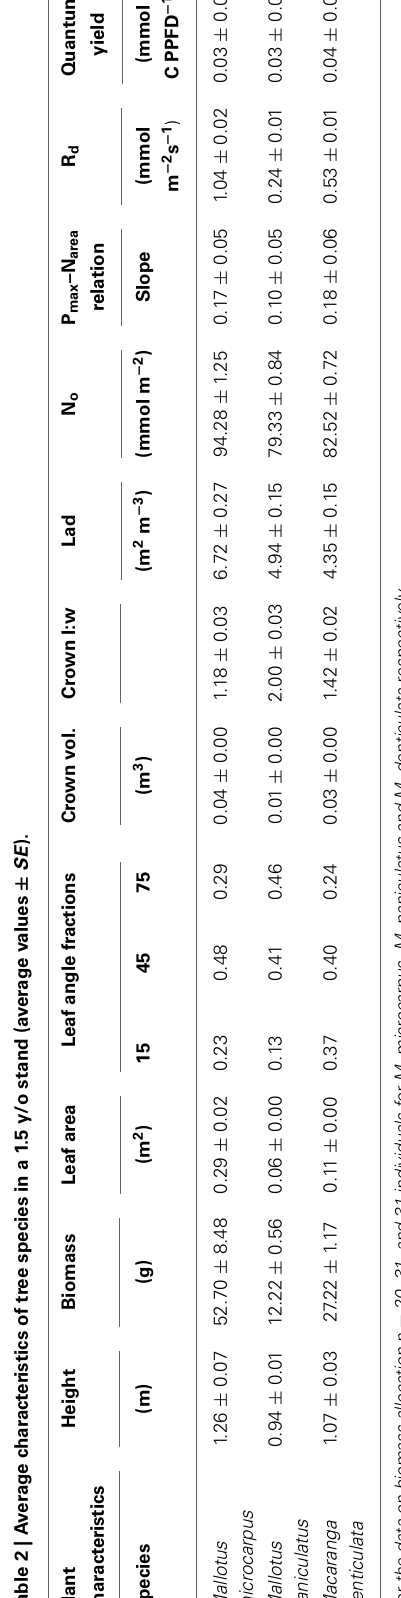
( Table 2 ). Average growth characteristics differed between liber- ated and control trees after liberation ( Table 3 ) with the liberated trees growing less in height, but more in